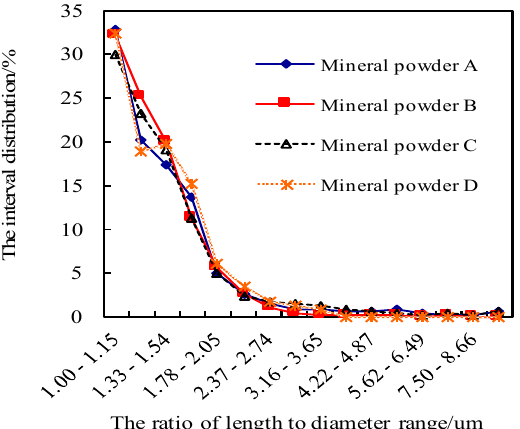
Figure 2. Difference in length to diameter ratio of the four kinds of mineral powder.